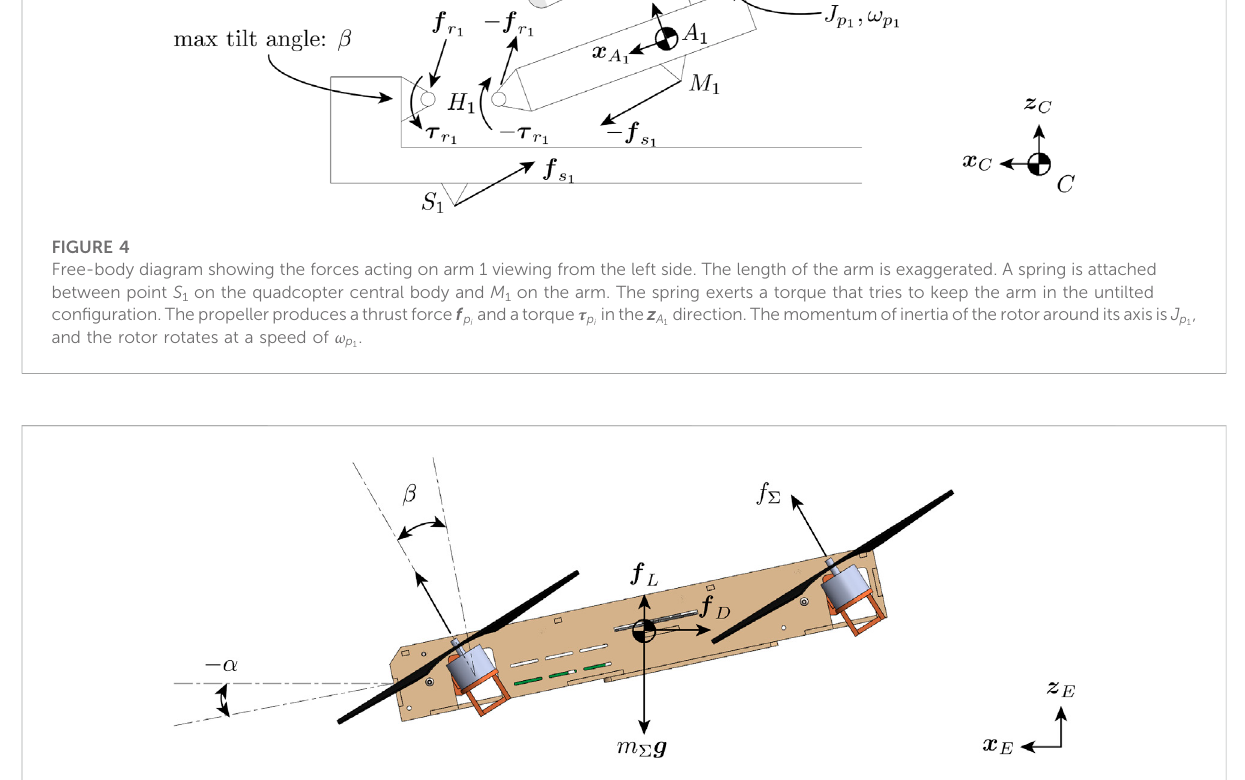
FIGURE 5 Free-body diagram of the vehicle when cruising. The tilt angle β is the angle between the arm and the central body, and the angle of attack α is the angle between the central body and the